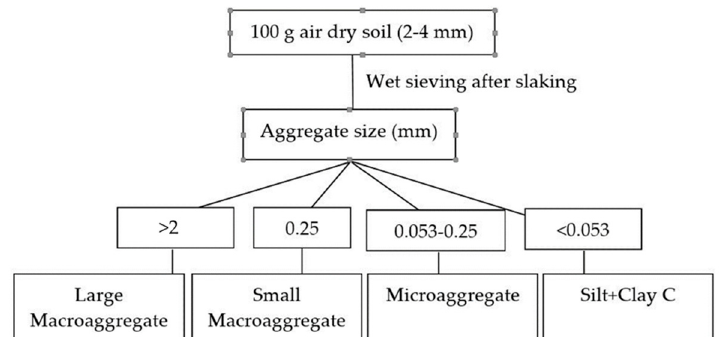
Figure 1. Fractionation scheme followed for soil aggregate analysis and its associated C. Note: Large macroaggregate (LMA) (>2 mm); Small macroaggregate (SMA) (>0.25 mm) and microaggregate (mA) (0.053–0.25 mm); Silt + clay (CSA) C (<0.053 mm).